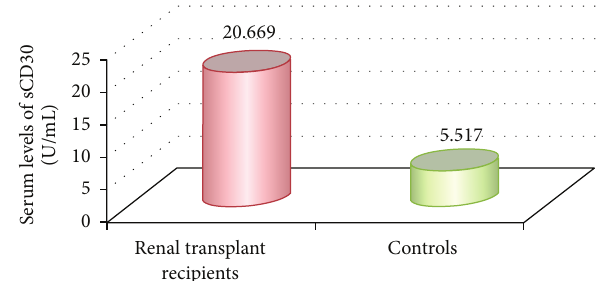
Figure 2: Mean serum level of sCD30 in renal transplant recipients and controls.